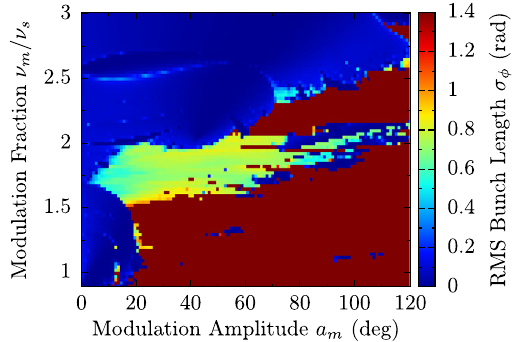
13. Parameter map of the rms bunch length σ ϕ as a function of the modulation amplitude a ν ¼ 30 °. The dark blue regions represent parameters = ν at Δ ϕ m s o where the particles are confined and no diffusion occurs. The dark red regions represent parameters where the diffusion is un- bounded and particles are lost.